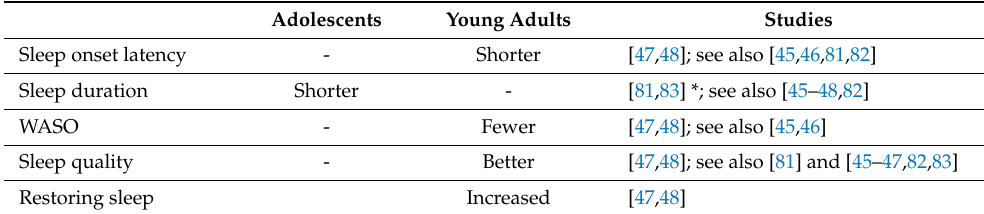
Table 1. Sleep variations in people experiencing romantic love (evidence from at least two